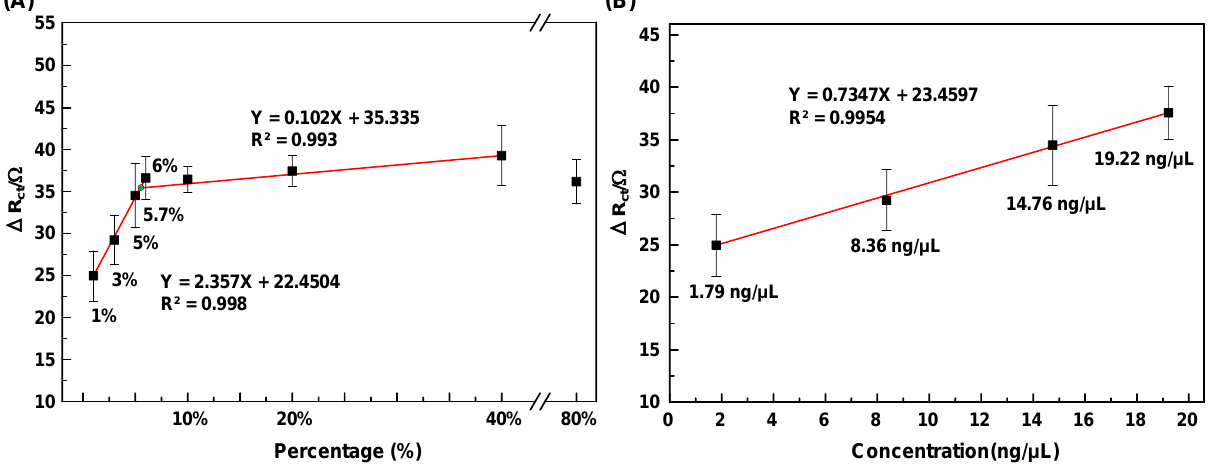
Figure 5. Standard curve for GMS detection. ( A ) Percentage stand curve, ( B ) concentration standard curve. Two target DNA samples, 4% and 5.7%, were used to verify the accuracy of the meas- urement using the concentration standard curve shown in Figure 5B. The results are listed